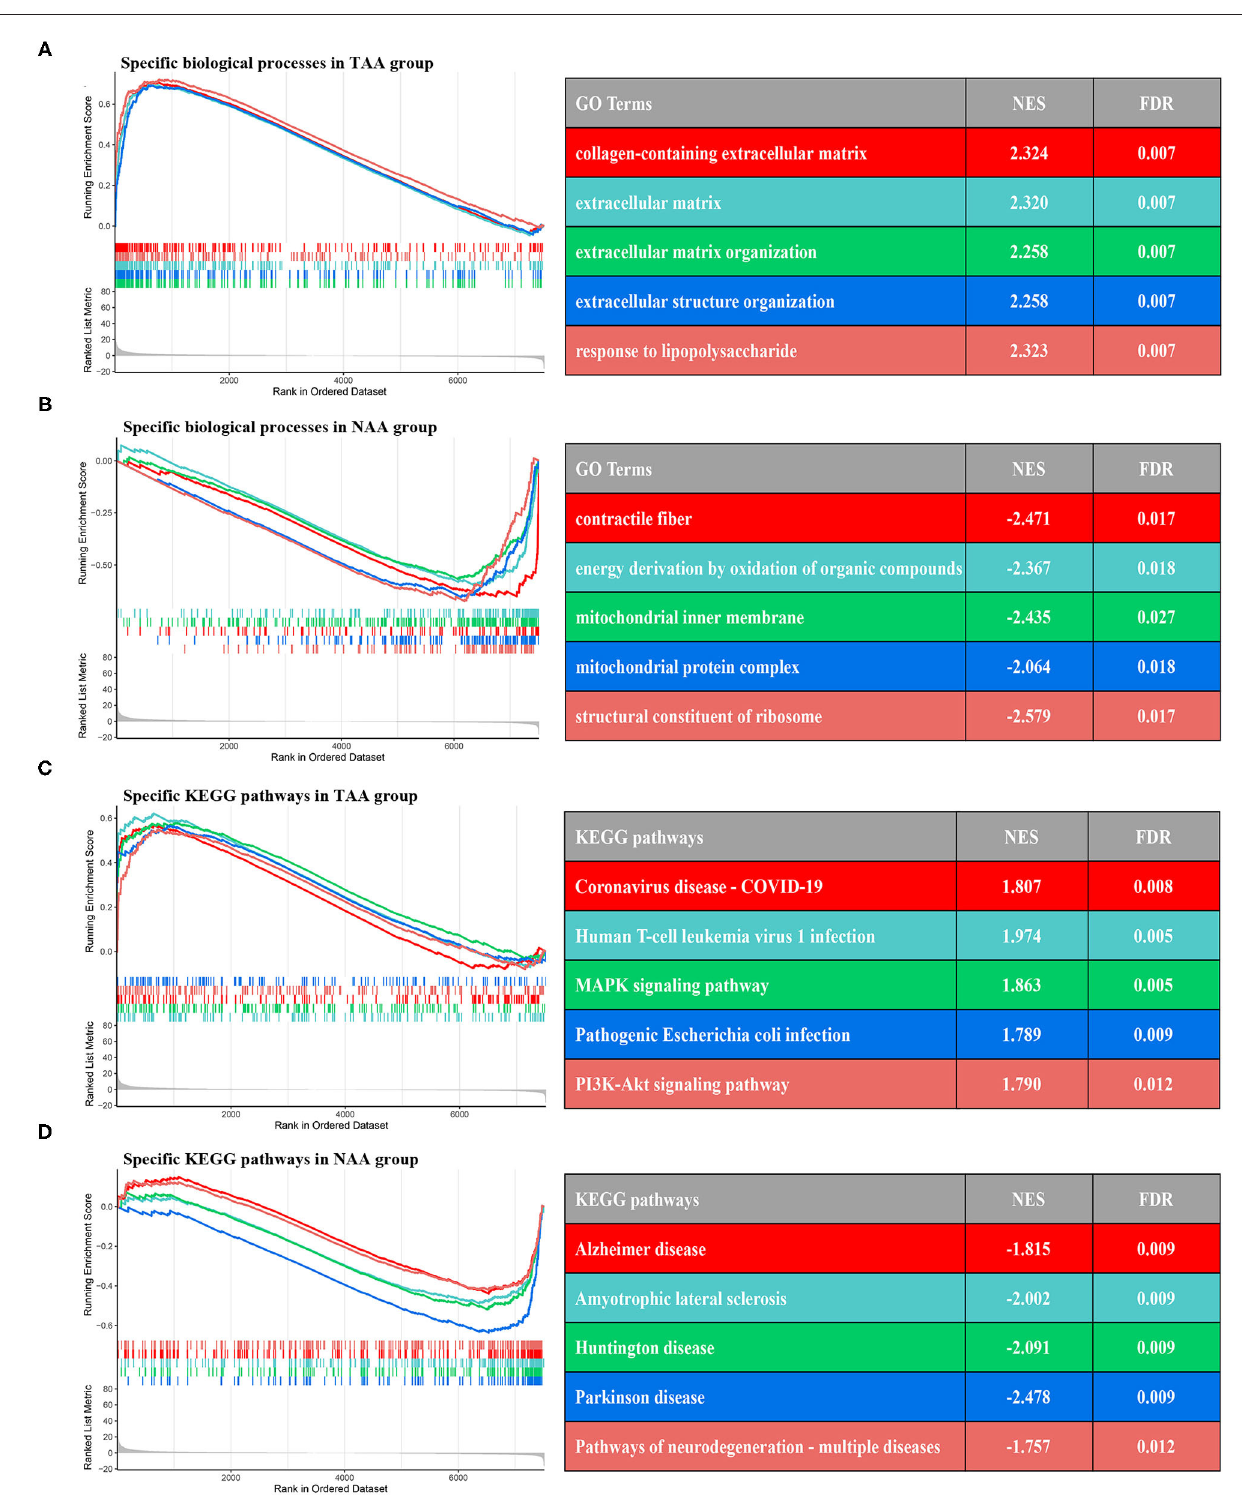
Frontiers in Cardiovascular Medicine |